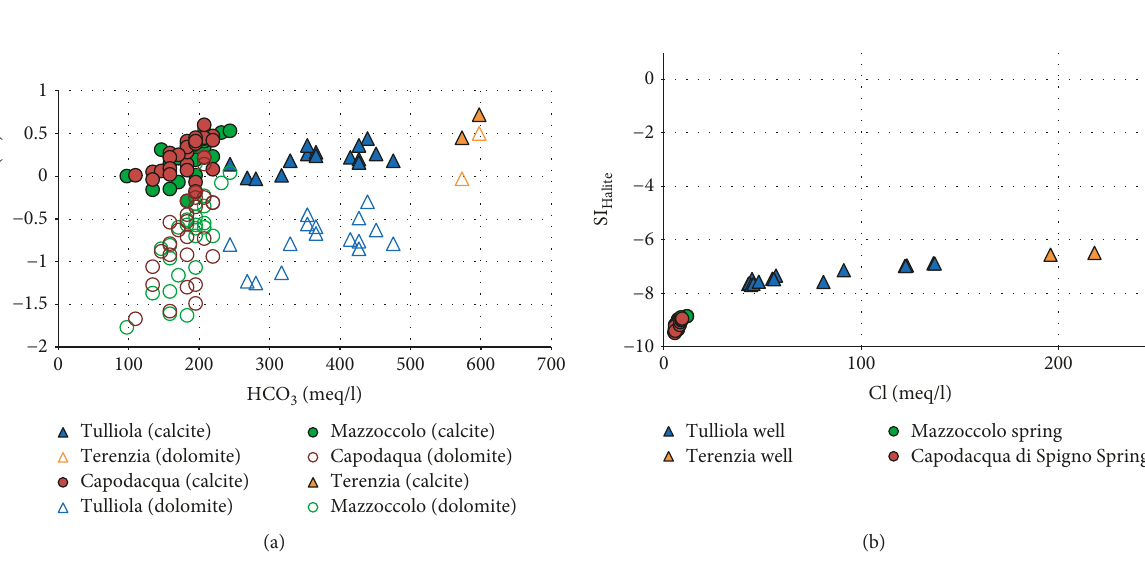
Figure 8: Saturation index (SI) values for the carbonate and evaporite minerals for the spring and well water samples. Calcite and dolomite saturation indices versus HCO 3- (a); halite saturation index versus Cl -